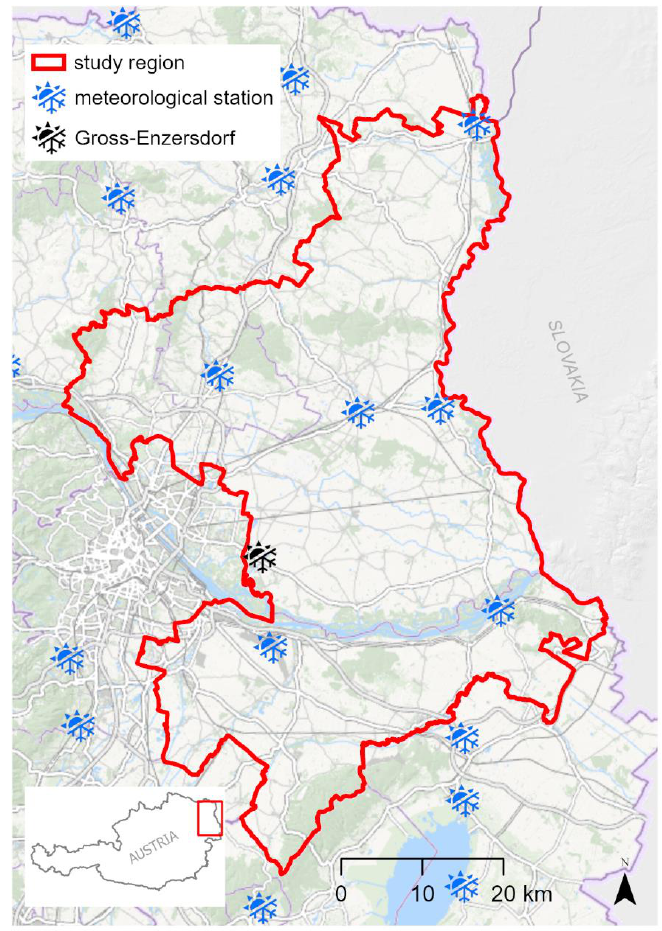
Figure 1. Location of the study region in Austria and meteorological stations used in this study. Gross-Enzersdorf is the meteorological station used for the general climatological description of the study region. For a complete list of meteorological stations, see Table S1.